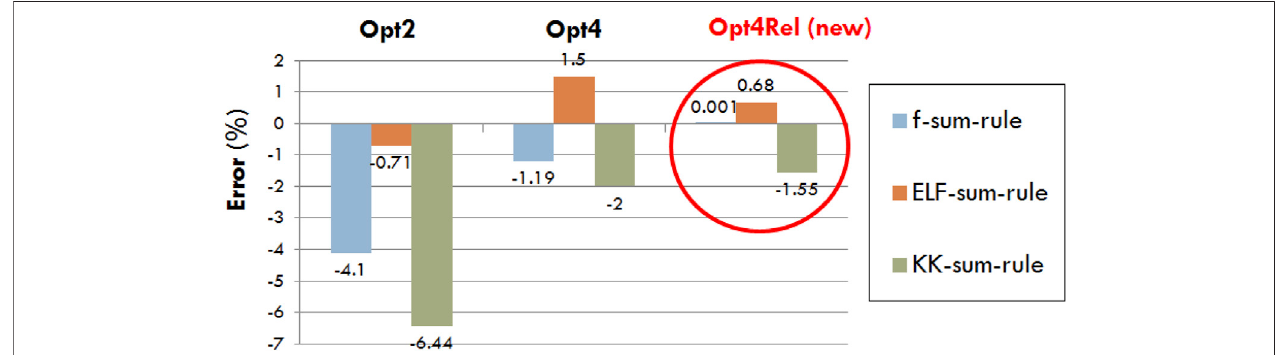
FIGURE 1 | Percentage error in the f-, ELF-, and KK-sum-rules for the existing (Opt2 and Opt4) and new (Opt4Rel) Geant4-DNA physics models.